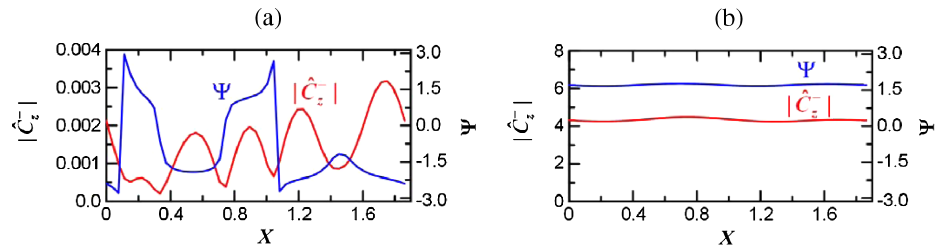
ˆ ˆ C − C − and phase Ψ ¼ arg at the up-stream edge of SWOs at the initial (a) and z j z